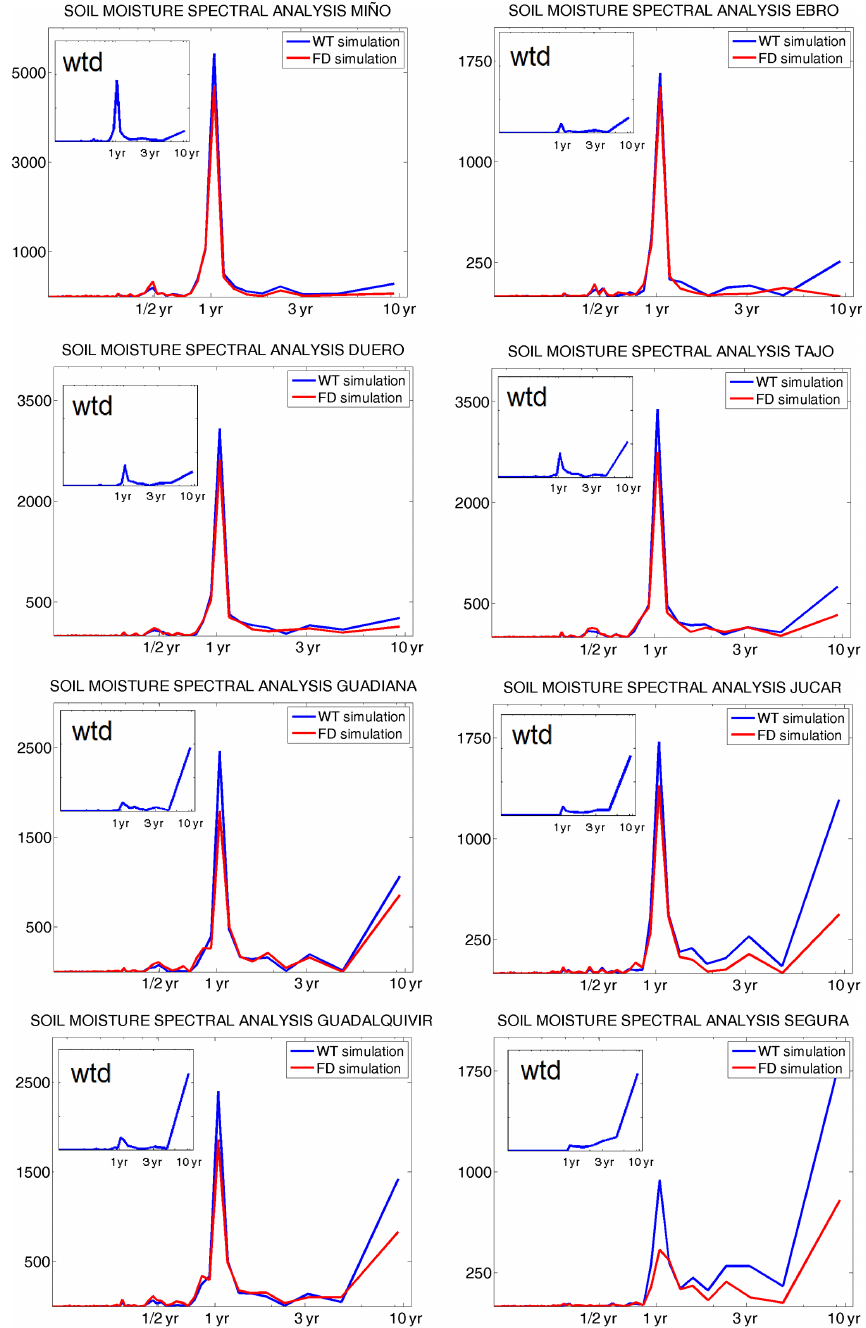
Figure 15. Power spectrum analyses over the main Iberian basins of top 2m soil moisture (WT run in blue and FD run in red) and wtd (insets). Only shallow water table cells (wtd ≤ 8m) within the basin are used. Basins are ordered, as in Fig. 14, from north (top) to south (bottom), and those on the left drain to the Atlantic and on the right to the Mediterranean, except for the Tajo, which is also an Atlantic